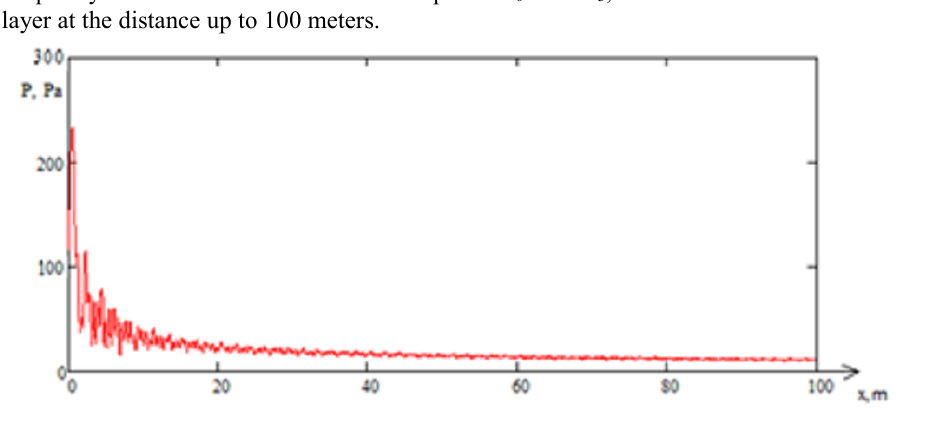
Fig. 2. Distribution of point source field amplitude for the frequency of 3000 Hz.